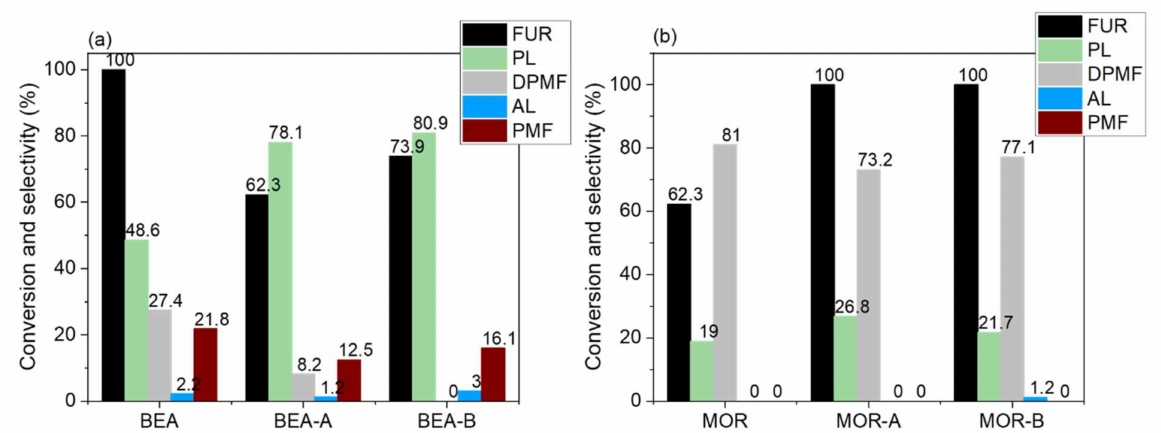
Figure 5. Catalytic evaluation of the commercial and treated zeolite ( a ) beta and ( b ) mordenite samples in the domino reaction of furfural upgrading. FUR = furfural conversion, PL = isopropyl levulinate, DPMF = 2-(diisopropoxymethyl)furan, AL = α -angelica lactone, PMF = 2-(isopropoxymethyl)furan. Reaction conditions: 0.34 mmol of FUR, 50 mg of catalyst, 1500 µ L of isopropanol, 110 ◦ C, and for 24